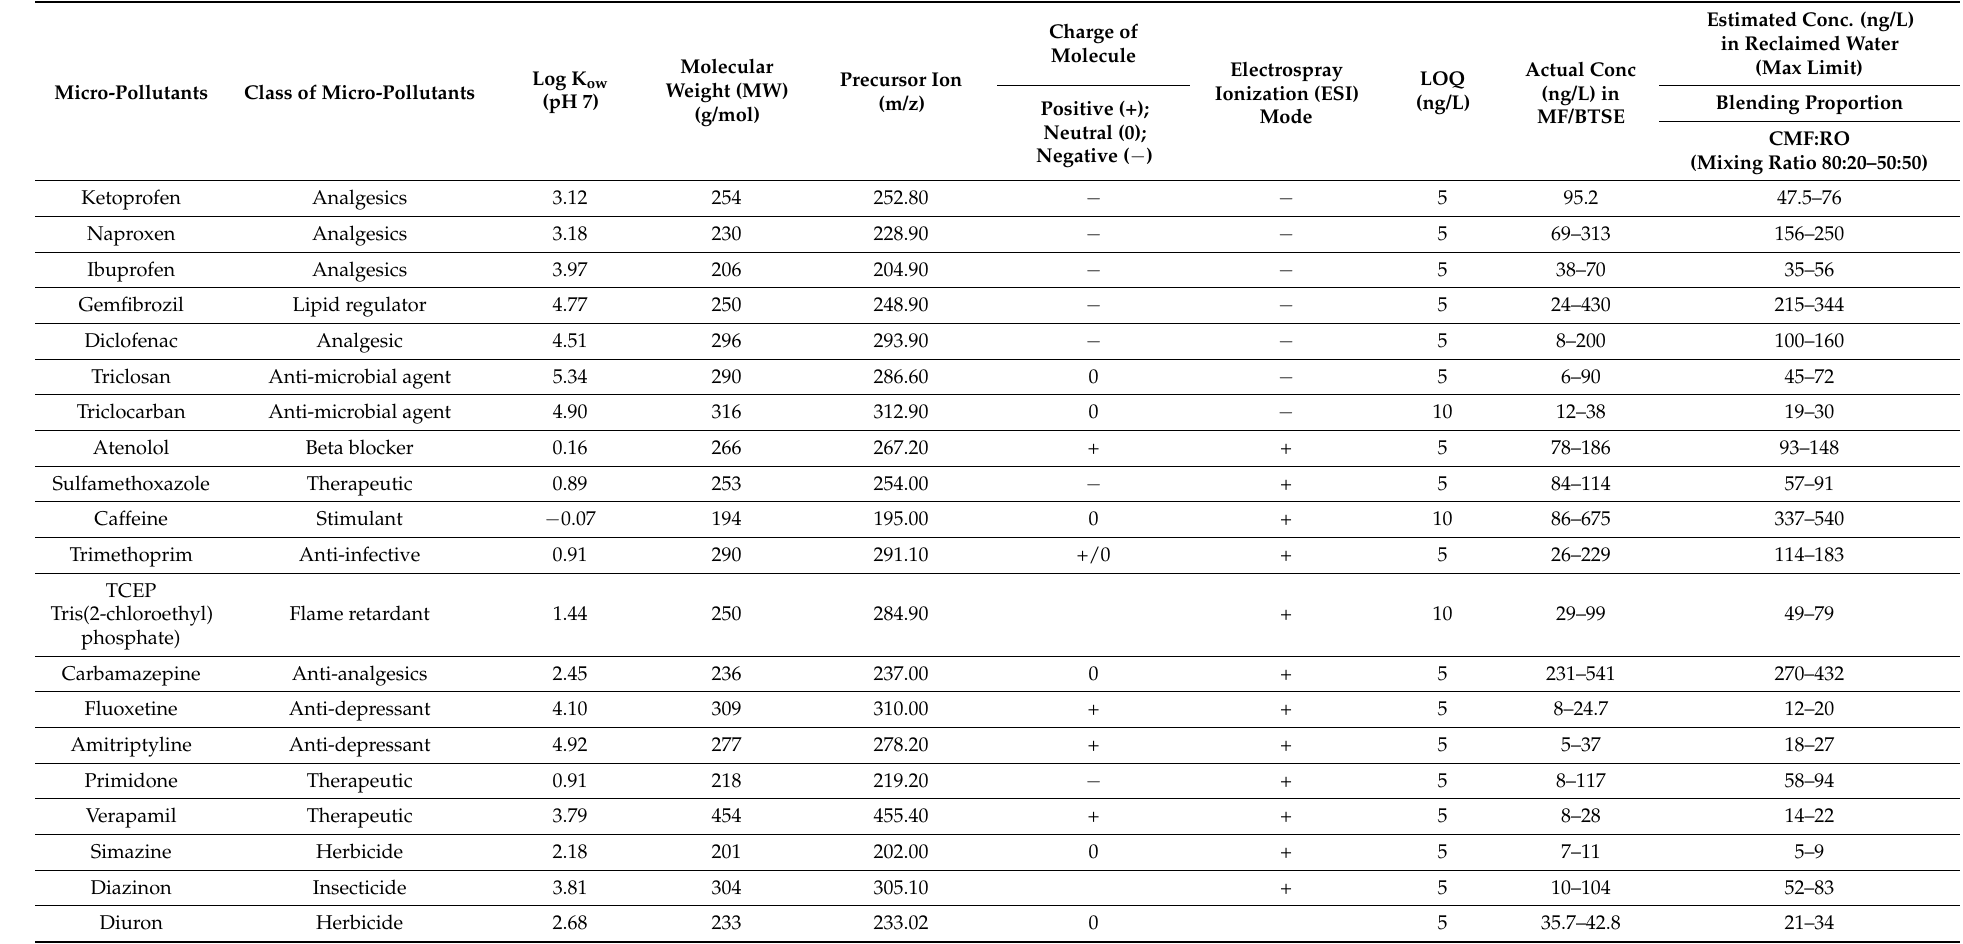
Table 1. Micro-pollutants in the MF/BTSE and recycled water